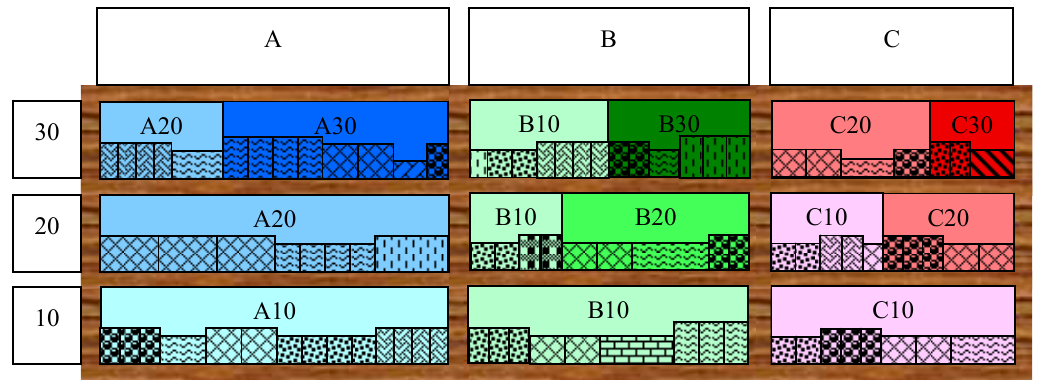
Figure 2. Allocation of the categories and price subcategories on the planogram.